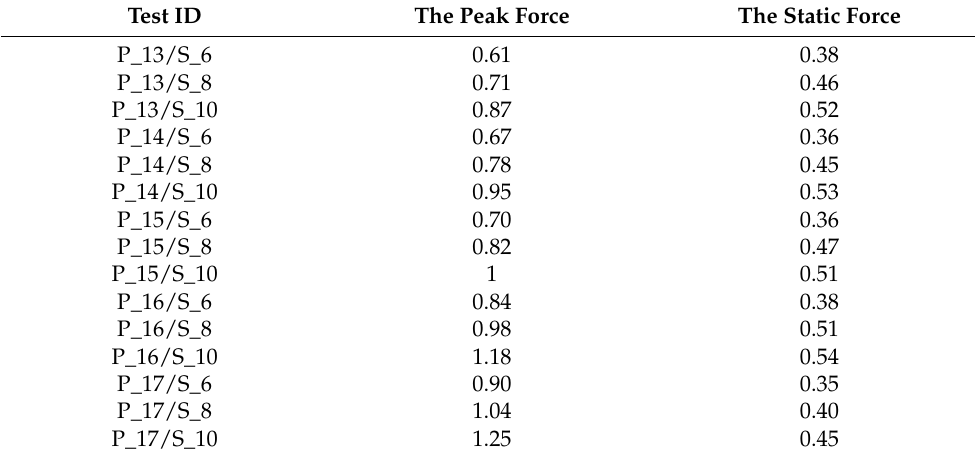
Table 3. The peak force and the static force normalized by the peak force of P_15/S_10.